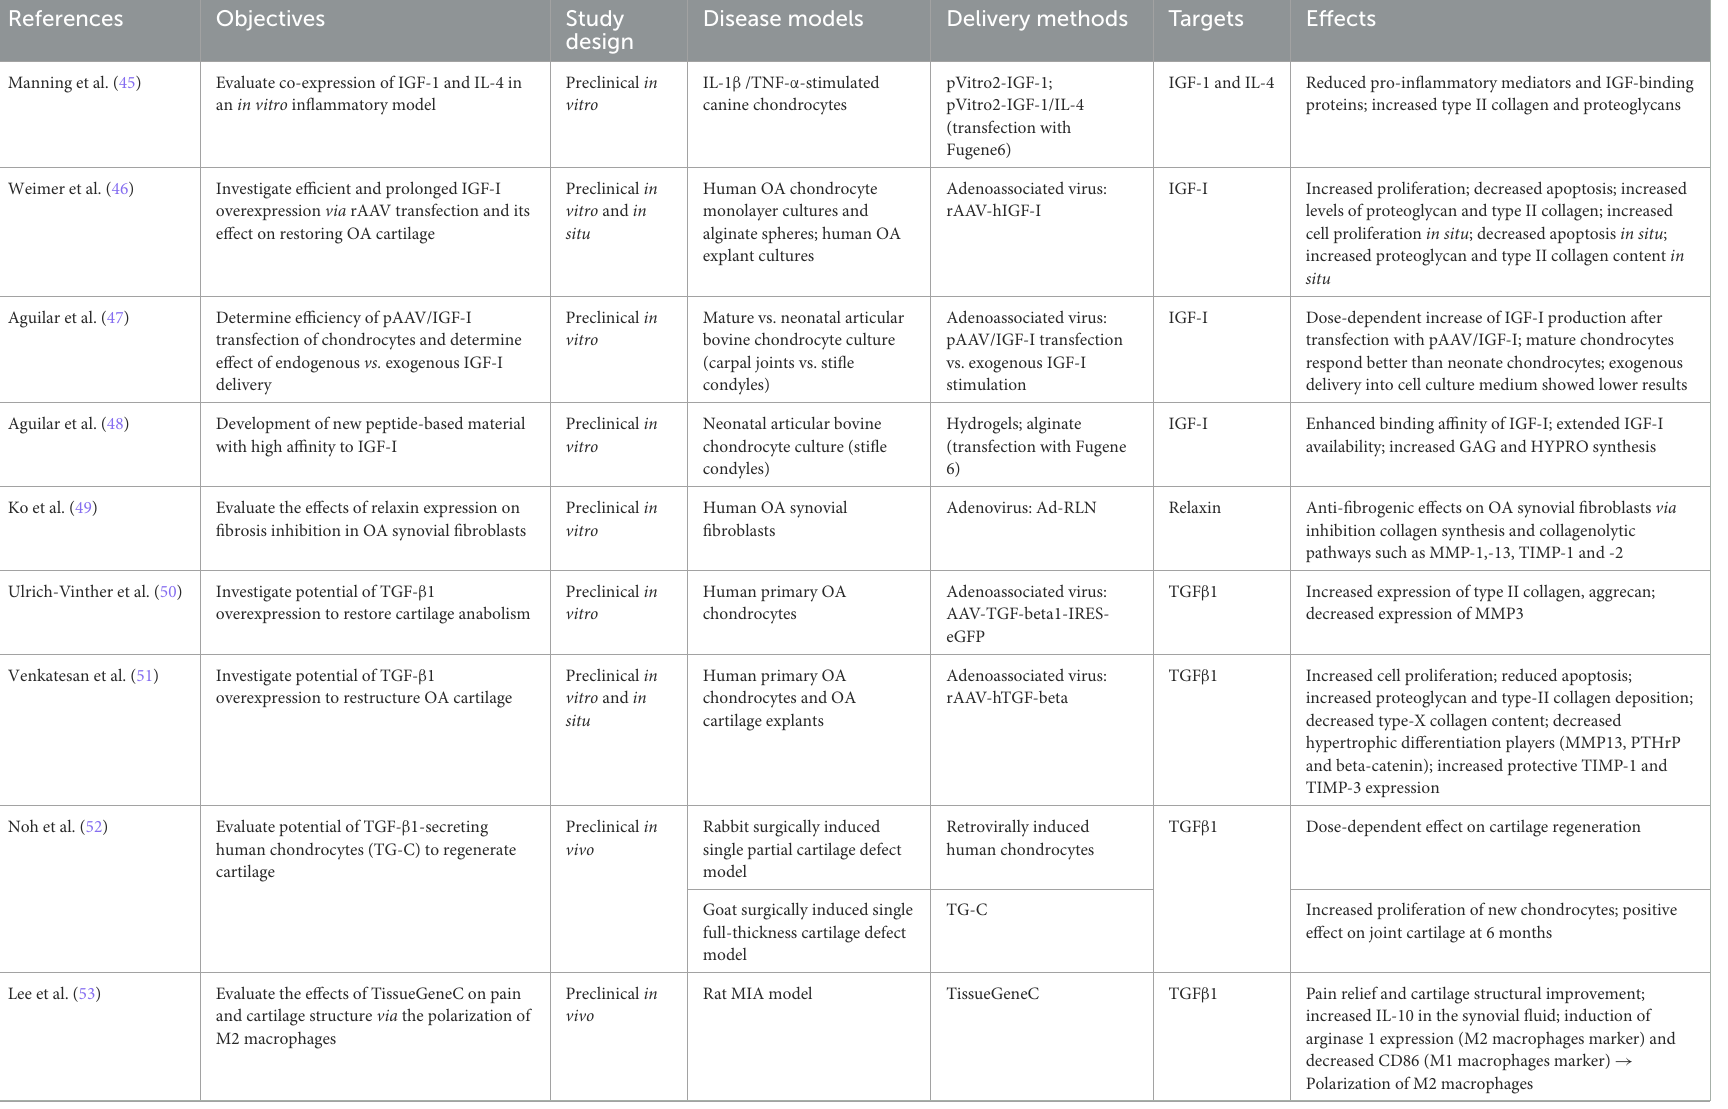
TABLE 2 Growth factors and